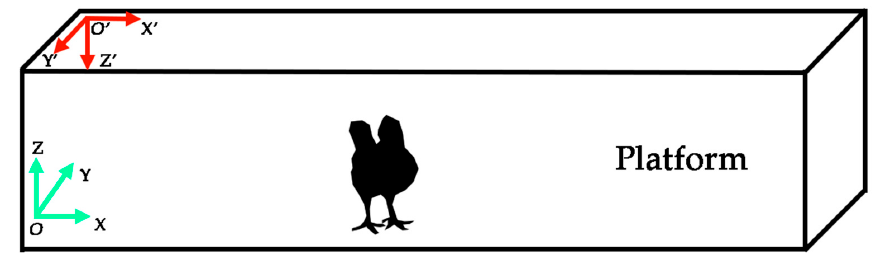
Figure 4. Coordinate systems for broiler locomotive-behavior analysis. O’-X’-Y’-Z’ is the image coordinate system, and O-X-Y-Z is the Cartesian coordinate system used for bird motion. Moving distances between adjacent frames were multiplied by the frame rate of video acquisition (30 fps) to obtain linear moving speed (mm ∙ s − 1 ) in the X and Y directions and multiplied by the frame rate of depth image acquisition (10 fps) to obtain the speed in the vertical (Z) direction. Similarly, the linear moving acceleration (mm ∙ s 2 ) along the three axes was acquired by dividing the difference in linear moving speed between adja- cent frames with respective time intervals. The linear moving speed and acceleration were calculated for each bird, and they were transformed to positives via the absolute operator for statistical analysis, for which only the absolute movement degree was compared. Forward-moving locomotive behavior was defined as a bird moving along the X -axis and can directly reflect a bird’s walking ability. Only the forward-moving duration (s ∙ bout − 1 ) during each moving event was calculated, because birds could be encouraged to move via human manipulation, and the results of other forward-moving locomotive behaviors (e.g., forward-moving bouts and forward-moving duration along the platform) could be interfered with. The calculation procedure of forward-moving duration per bout is presented in pseudocode form as Algorithm 1. The program compared the moving dis- tance between adjacent frames (with a time interval of 1/30 s), and birds were defined as being forward-moving when the distance was more than 5 mm, which was the minimum threshold based on the validation of a moving bird from the top-view videos. Some elec- tronic noise in the images could also result in an instantaneous distance change between adjacent frames, and this noise could be filtered if a duration for the change was set. There- fore, if birds continued to move over 3 frames (~0.1 s), the forward-moving duration was stored for further processing.